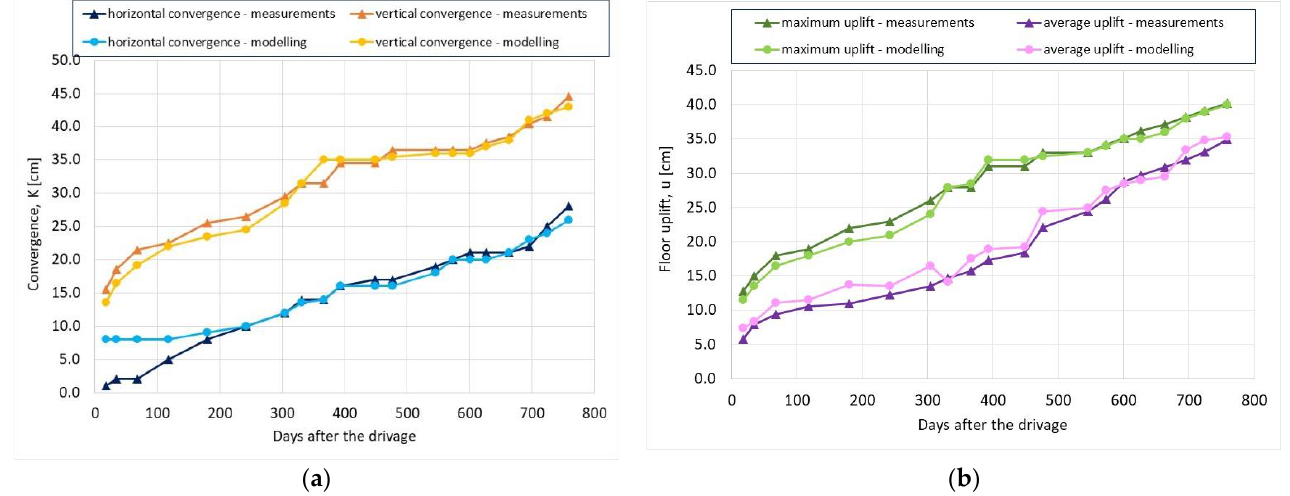
Figure 10. The consistency between numerical modeling and underground measurements of roadway D-2 deformation — chainage 595 m. ( a ) Convergence. ( b ) Floor uplift. D-2 deformation—chainage 595 m. ( a ) Convergence. ( b ) Floor uplift.